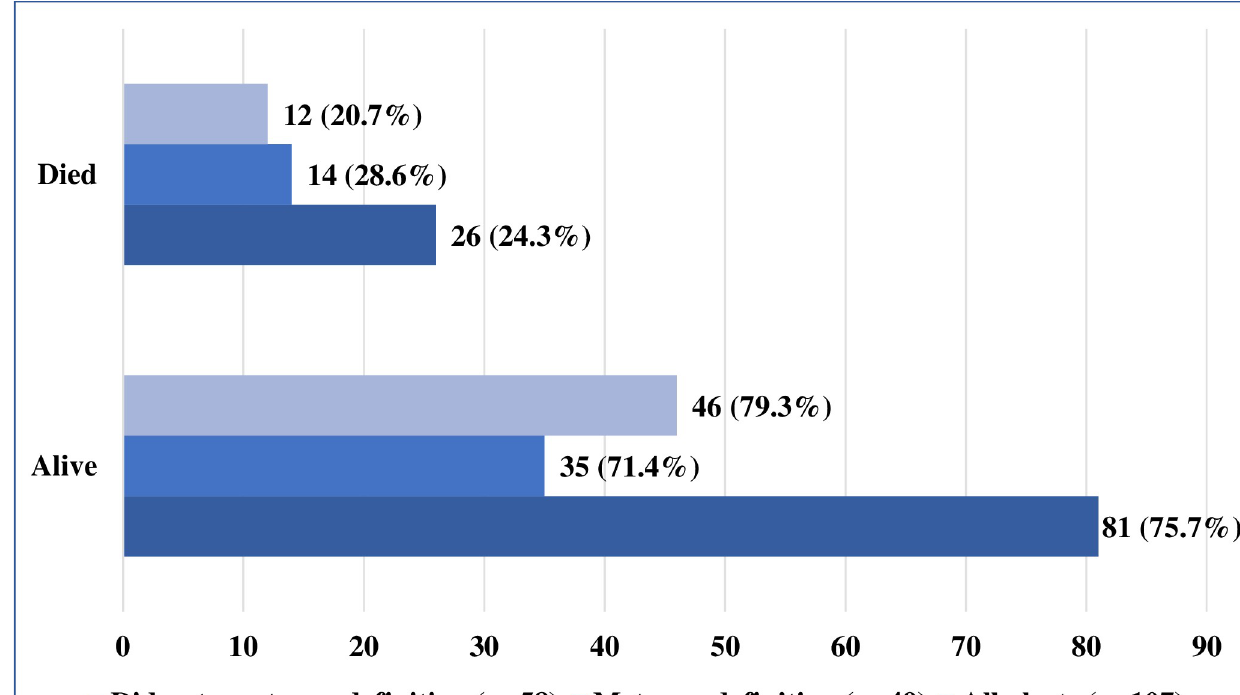
Fig 2. Status of EVD alerts in South Sudan—August 2018 to November 2019.